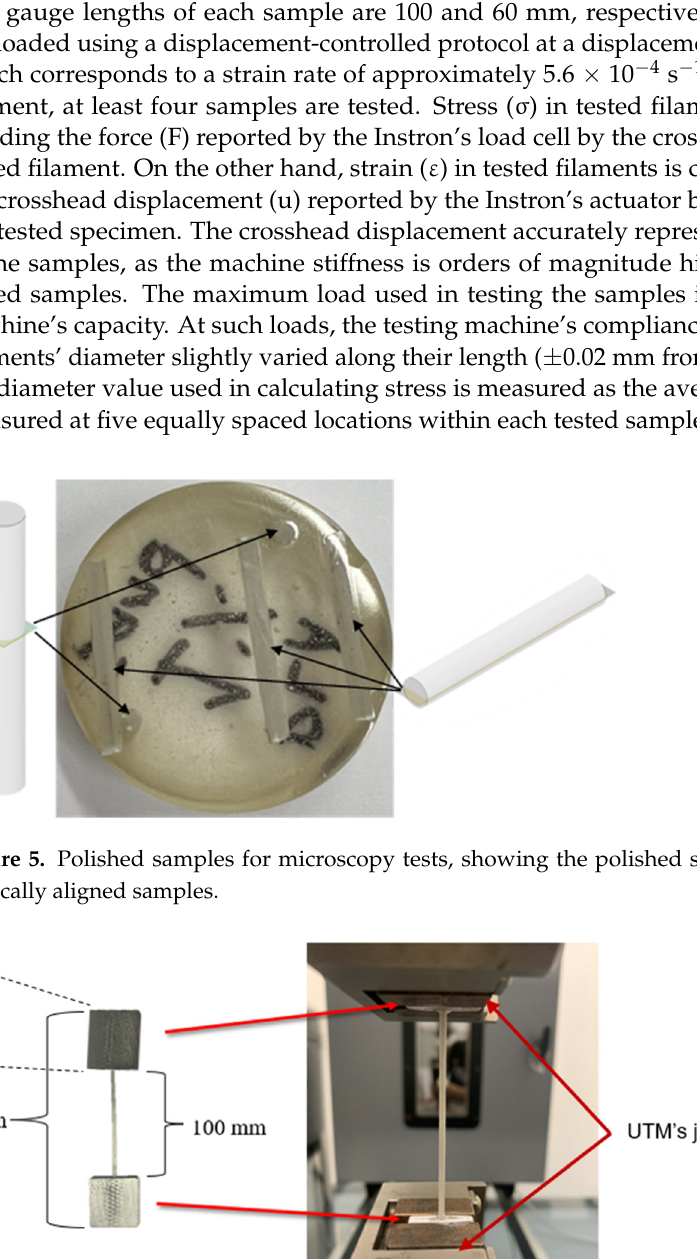
Figure 4. Sample of the fabricated PLA-sand filaments with 20 and 0.5 wt% sand.